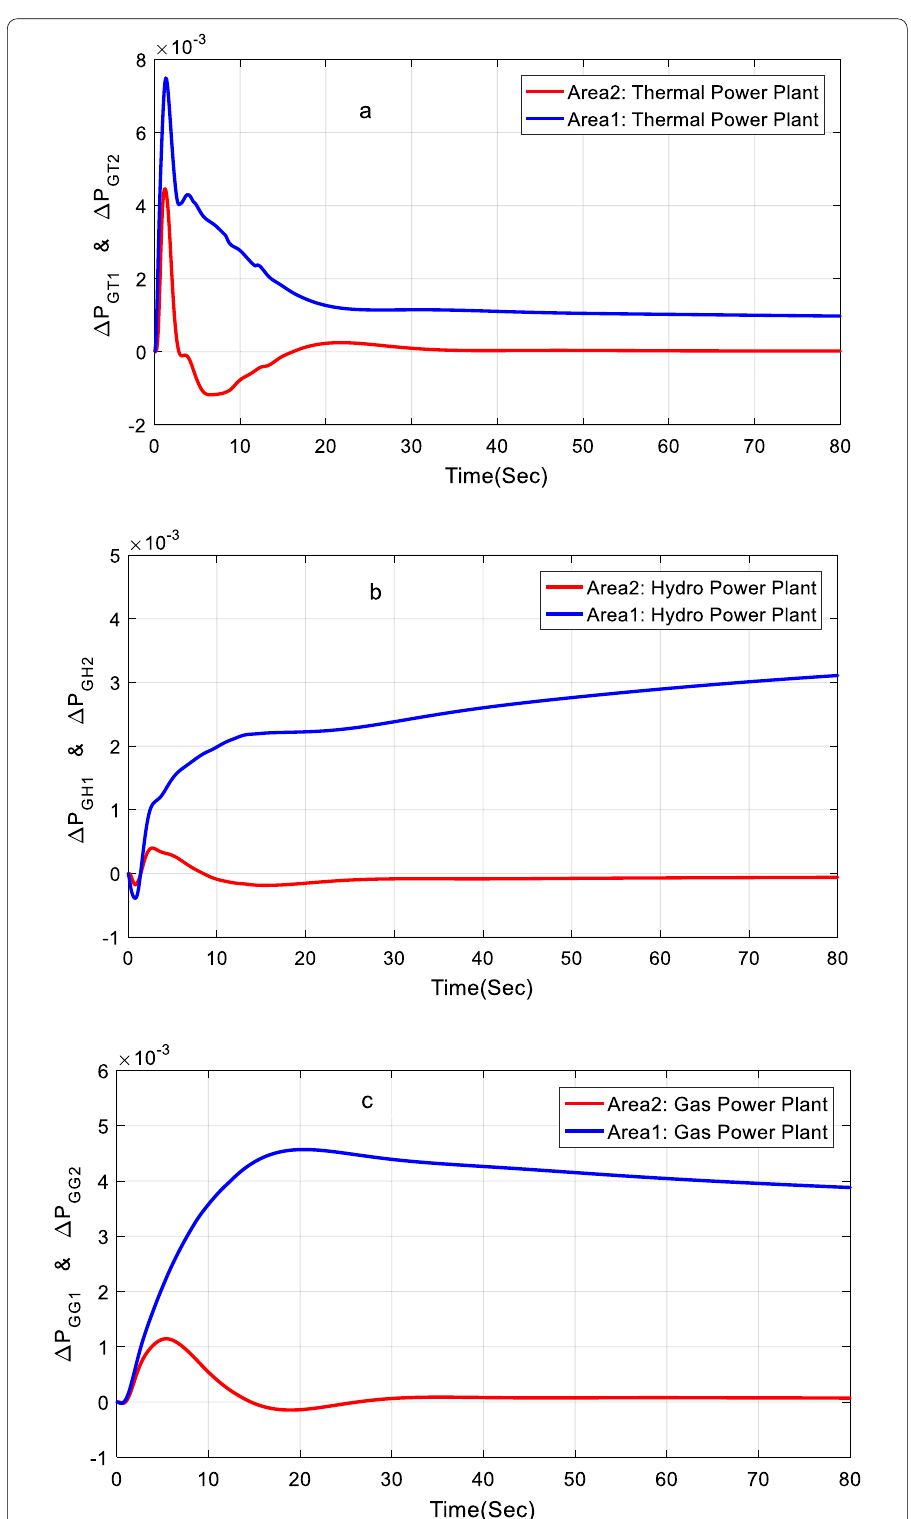
Fig. 7 System response (� P D 1 = 0.01 p . u . MW & � P D 2 = 0 ) with HVDC link. a Deviation in generated